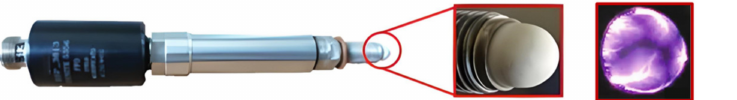
Figure 3. Barrier Discharge Igniter with focus on the streamers’ evolution around the firing end.